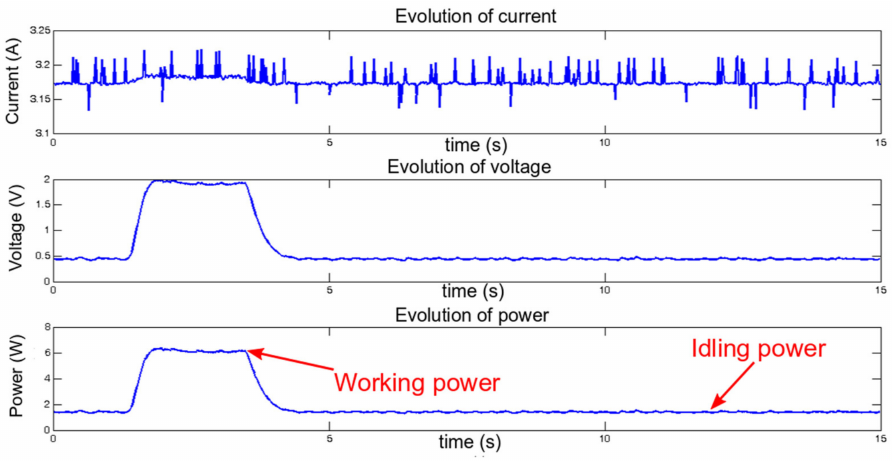
Figure 2. Evolution of power during a slotting test.